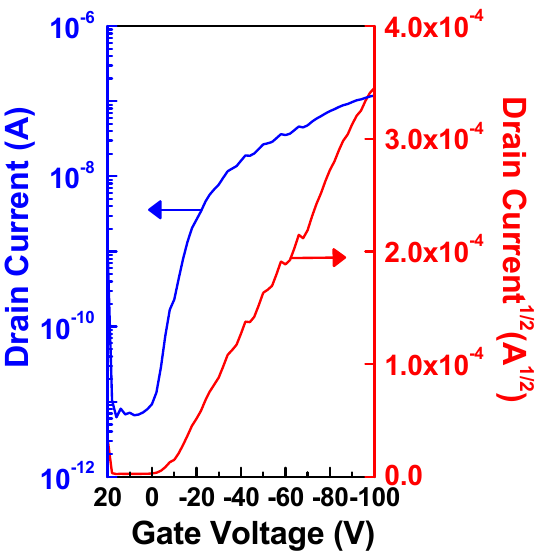
Figure 4. Transfer curve of POTV OFET device. Table 3. The organic thin-film transistor performances of POTV (Run 6)